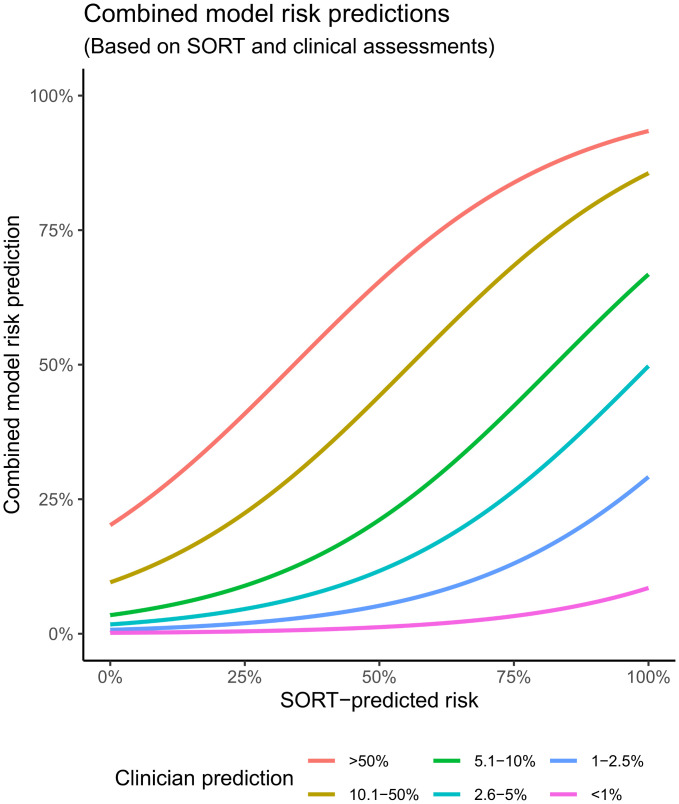
Predicted risks from combined model, stratified by clinical assessments.We model the changes to risk predictions (y-axis) based on subjective clinical assessments (coloured lines) as SORT-predicted risks (x-axis) change, to illustrate the change in risk predictions if information from both are combined. P-POSSUM, Portsmouth-Physiology and Operative Severity Score for the enUmeration of Mortality; SORT, Surgical Outcome Risk Tool; SRS, Surgical Risk Scale.